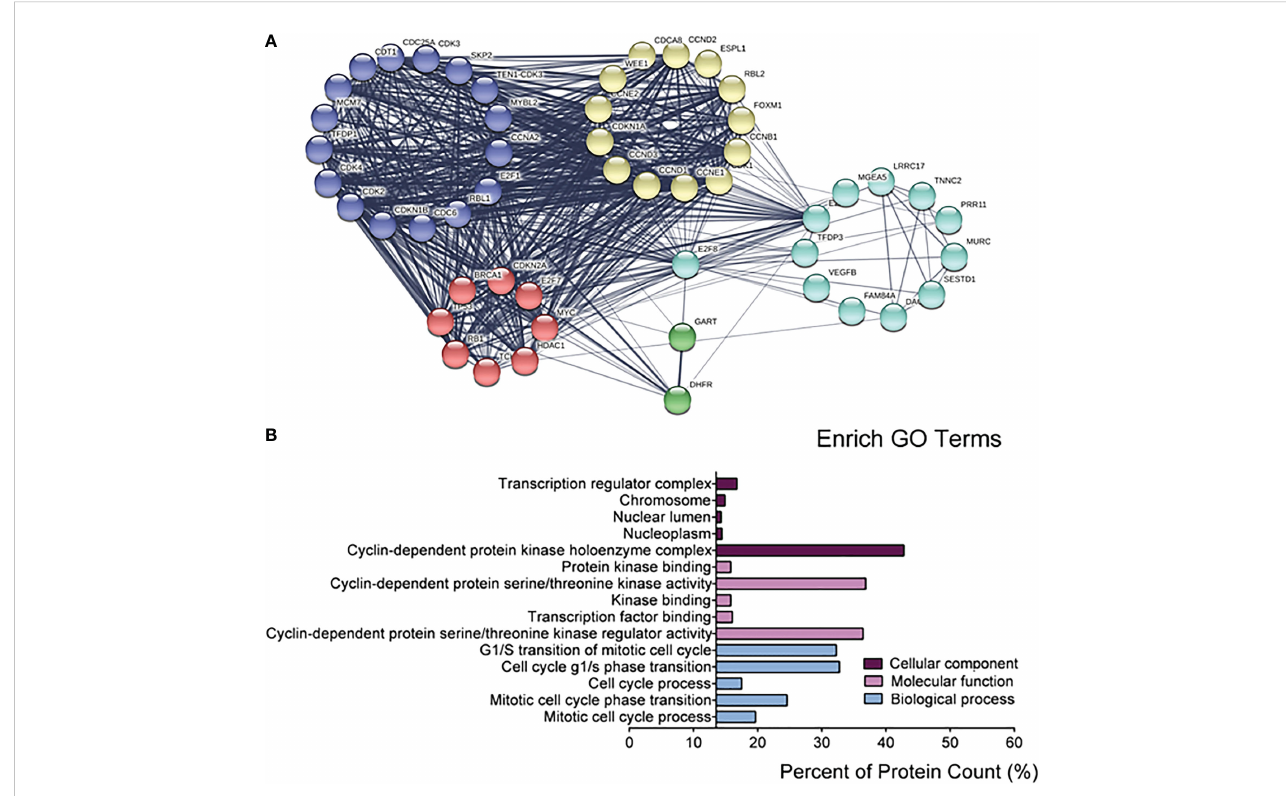
FIGURE 3 The regulatory networks for E2F8. (A) The depiction analysis between E2F8 and coexpressed proteins using the STRING datasets. (B) The converged GO analysis for E2F8 and its coexpressed proteins, including cellular components, molecular function, and biological process, using the GraphPad Prism